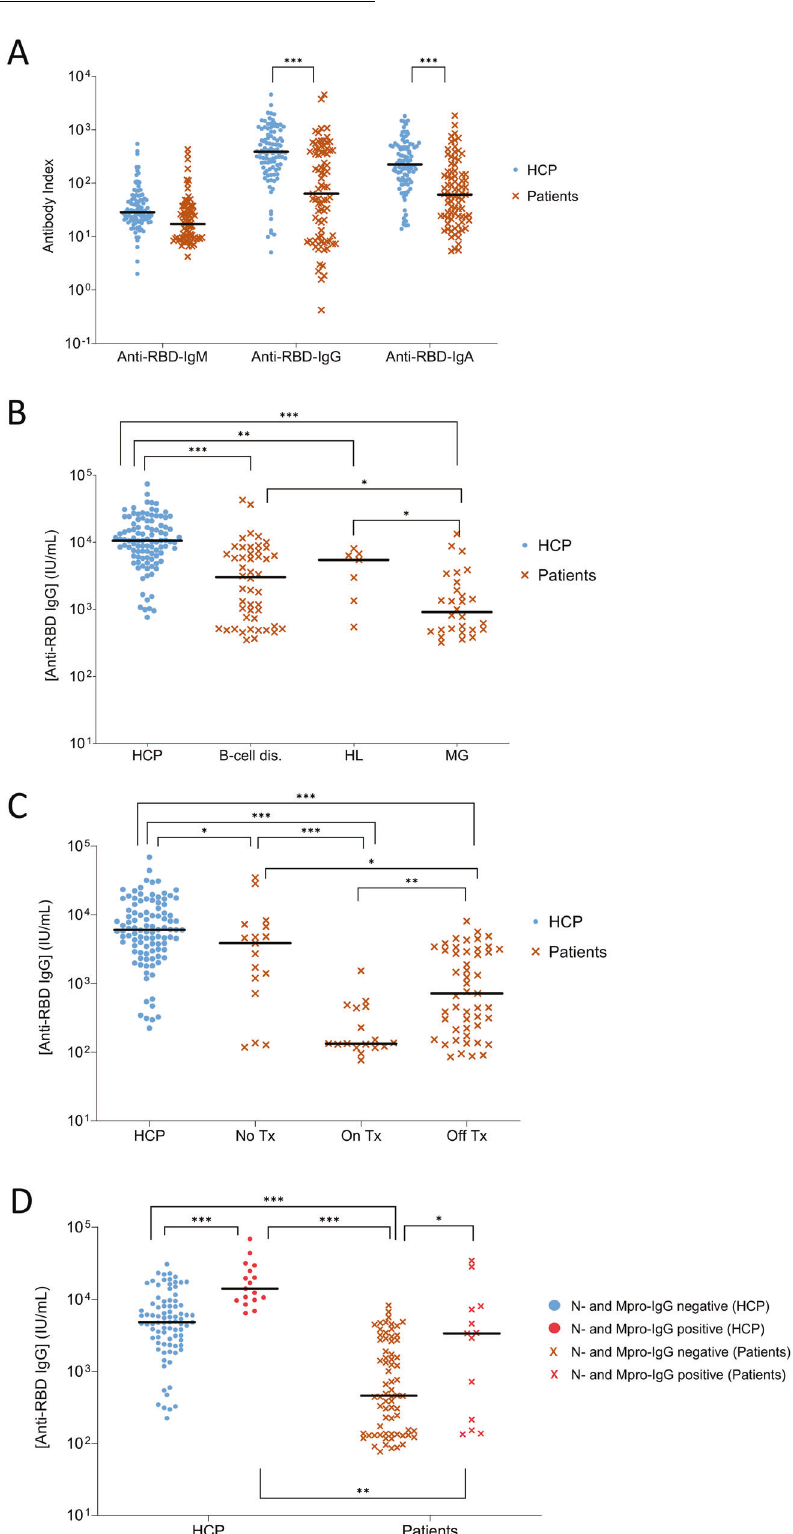
Fig. 4 Antibody response in hematological patients and HCP. A Index of IgM, IgG, and IgA antibodies against the receptor-binding domain (RBD) of the S-glycoprotein in health care practitioners (HCP, N = 102) and hematological patients ( N = 83). B Concentration of anti-RBD IgG in HCP, hematological patients with B-cell lymphoproliferative disorders (B-cell dis., N = 48), monoclonal gammopathies (MG, N = 28) and Hodgkin lymphoma (HL, N = 7). C Concentration of anti-RBD IgG in HCP, hematological patients that had never received treatment (No Tx, N = 17), those that were on ( N = 17), and patients that were off-treatment ( N = 49) before vaccination. D Concentration of anti-RBD IgG in HCP and hematological patients with or without previous SARS-CoV-2 infection, based on the detection of IgG antibodies against the nucleocapsid (N) protein and the main virus protease (Mpro). Among HCP, 85 were negative and 17 positive for both antigens. Among hematological patients, 70 were negative and 13 positive for both antigens. In all panels, horizontal lines represent the median. * P < 0.05; ** P < 0.01; *** P <